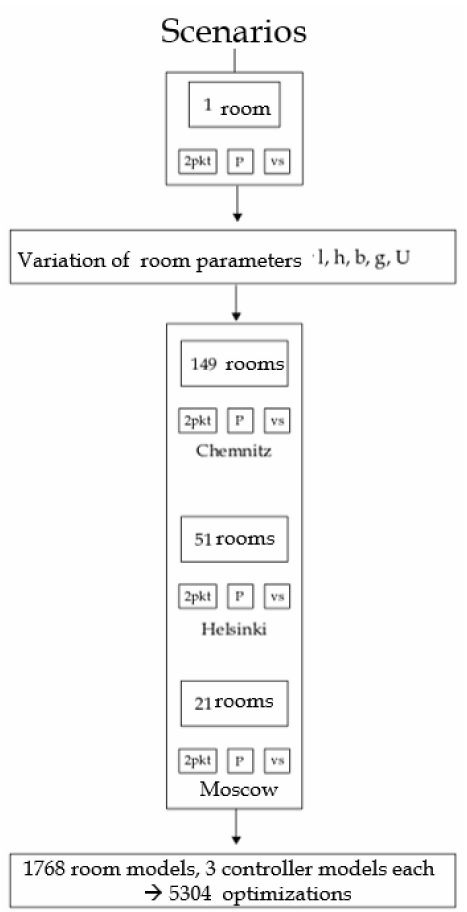
Figure 8. Composition of the data basis (Supplementary Materials).